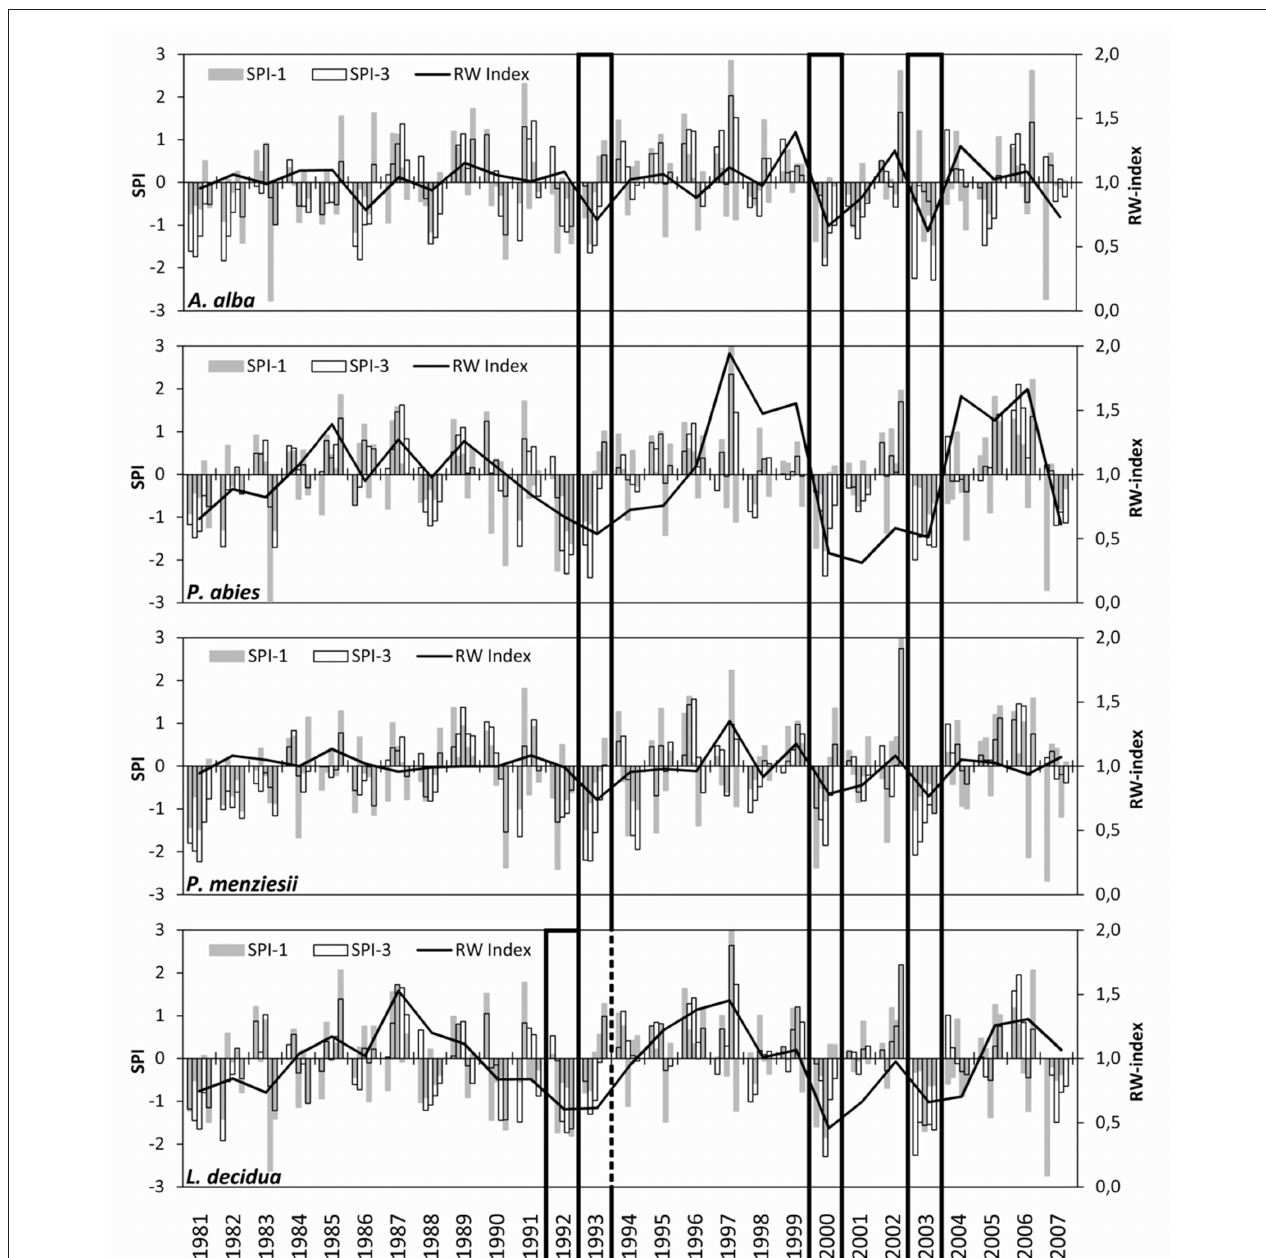
FIGURE 2 | Drought occurrence and resulting increment declines on four conifer trial sites in the Northeast of Austria. The bars show the standardized precipitation index SPI (given in standard deviations) on time scales of 1 (SPI-1) and 3 (SPI-3) months. The line plots illustrate the course of an annual increment (as a dimensionless ring-width index). Frames mark the most significant and common drought periods that are used for comparison among trials and